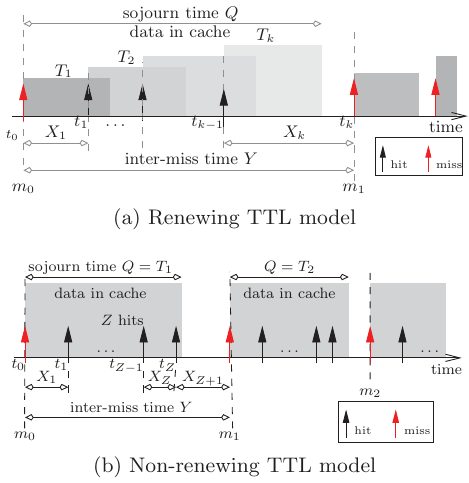
Figure 2: Behaviour of a file in the